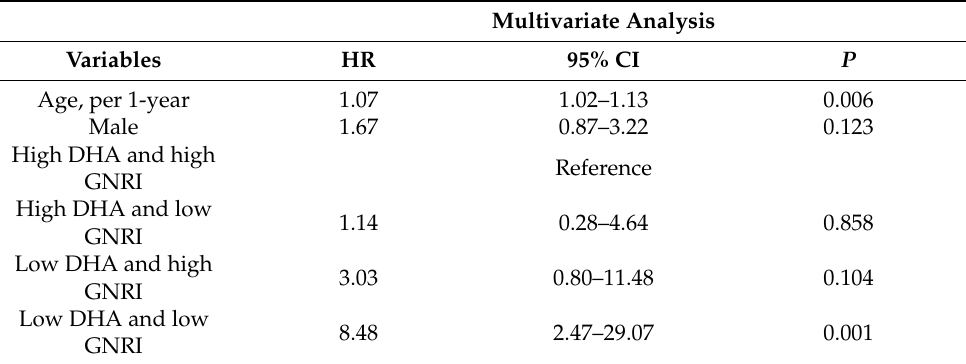
Figure 3. The associations between the primary outcomes and the DHA and GNRI values. The cumulative incidences of the primary endpoint (all-cause death) were estimated by using the Kaplan–Meier method. Log-rank testing was performed to study the influence of PUFA levels on primary endpoint. The patients were divided into four groups, based on the median DHA and GNRI values. DHA, docosahexaenoic acid; GNRI, geriatric nutritional risk index. Table 3. The association between the DHA and GNRI values and primary endpoints analyzed with Cox proportional hazards models.